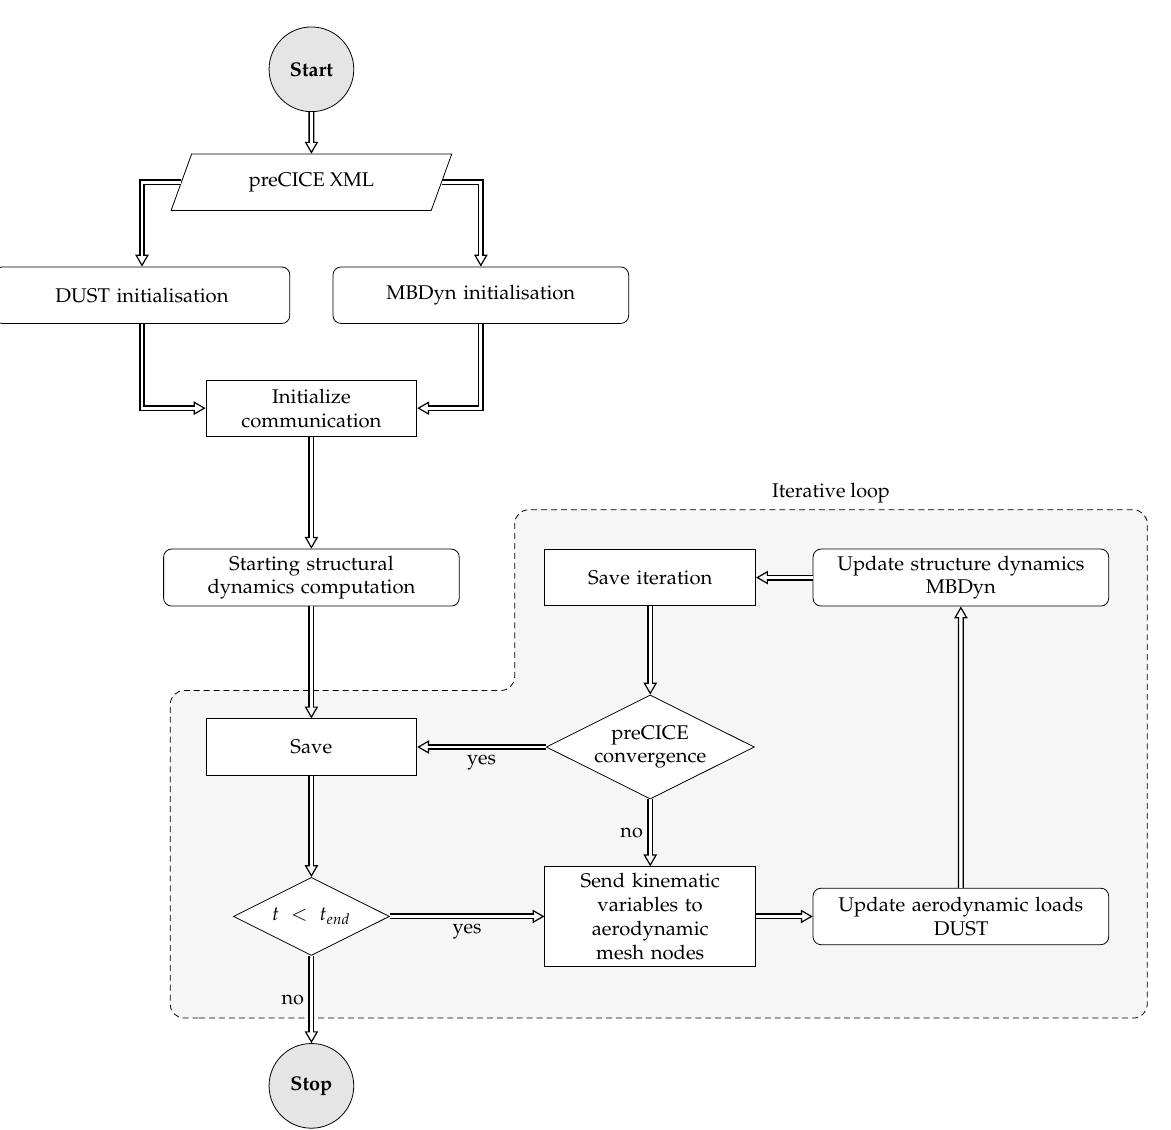
Figure 3. Flowchart of the implicit communication managed by preCICE between DUST and MBDyn [39].